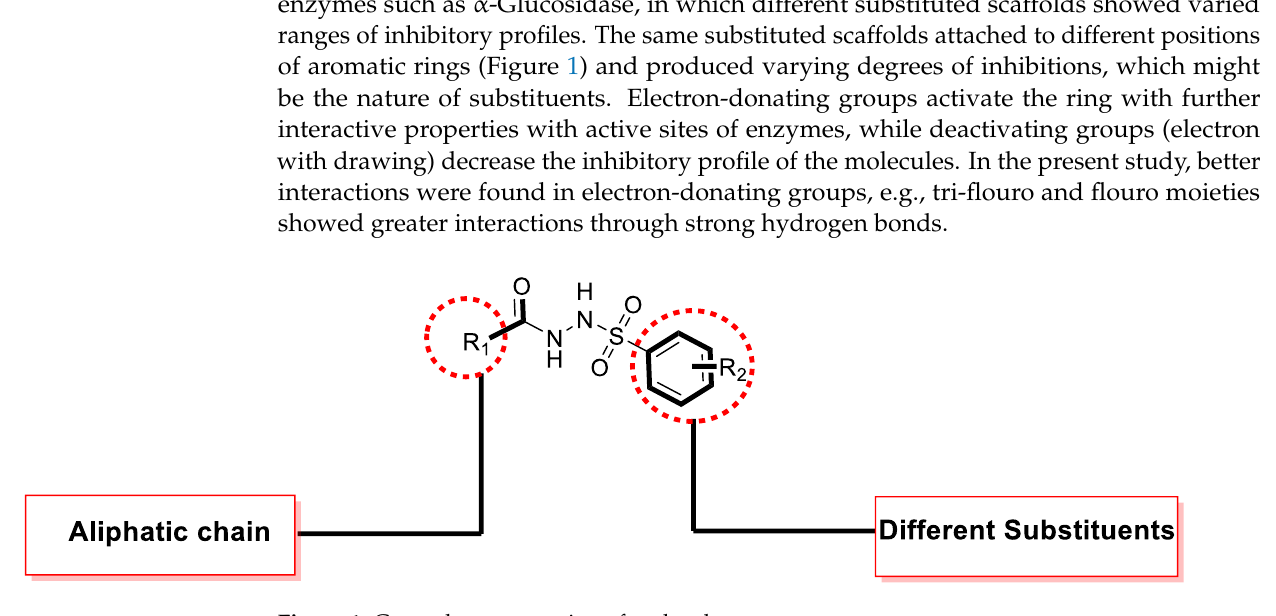
Table 1. Different substituted sulphonamide derivatives with inhibitory profile ( 1 – 15 ).